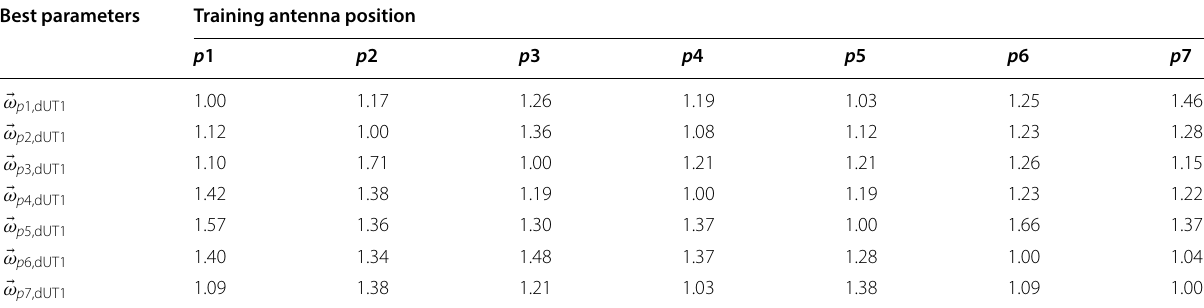
Similar results can be seen for the 6 1 and 12 1 networks and all EOP. Values larger than 1.00 indicate how much the results degrade when not using the optimum + + weighting scheme for a particular training antenna position